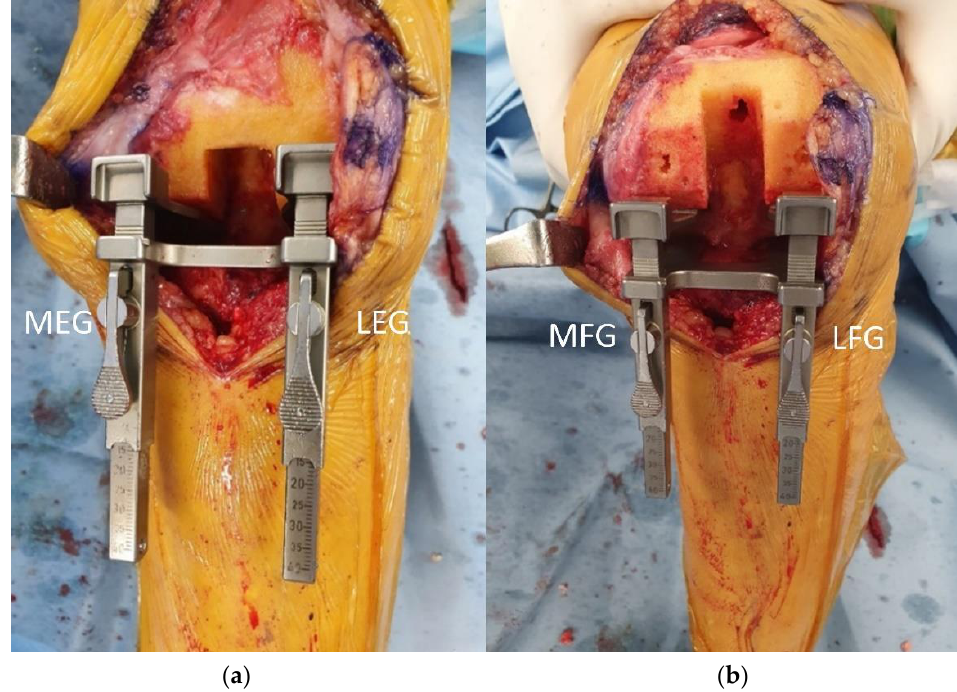
Figure 2. Measuring four total knee arthroplasty gaps (MFG, LFG, MEG, LEG) using a device similar to a lamina spreader and a tensor with a slide ruler. ( a ) Measurement of extension gaps (MEG, LEG). ( b ) Measurement of flexion gaps (MFG, LFG); MEG: medial extension gap; LEG: lateral extension gap; MFG: medial flexion gap; LFG: lateral flexion